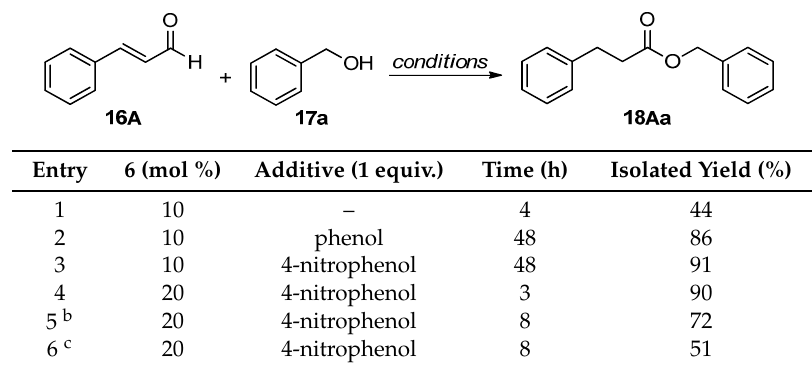
Table 4. NHC ‐ catalyzed redox esterification reactions using polymer 6 a .